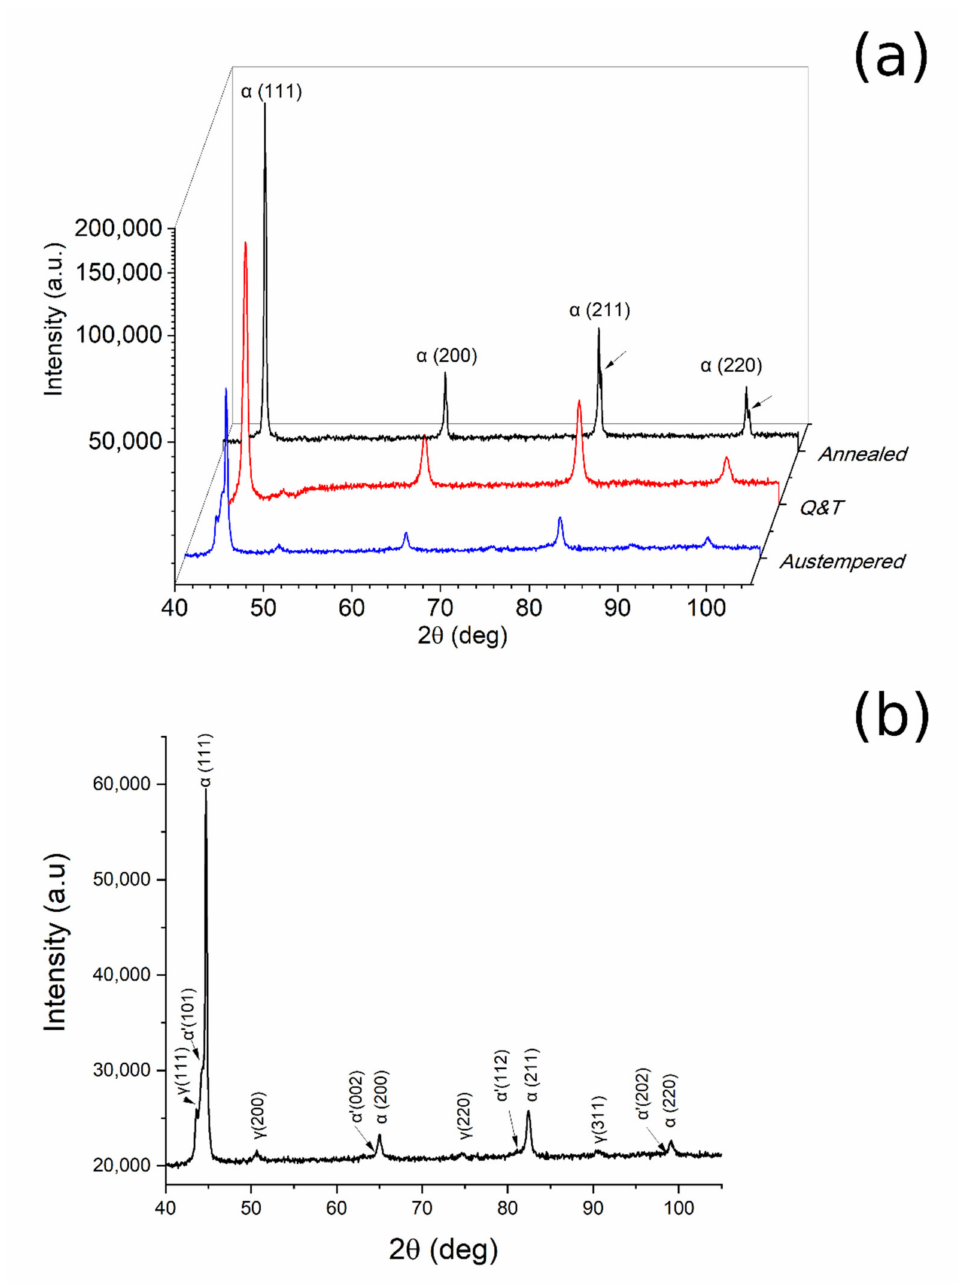
Figure 10. X-ray di ff raction pattern of high silicon steel after each heat treatment ( a ), X-ray pattern of austempered steel in detail ( b